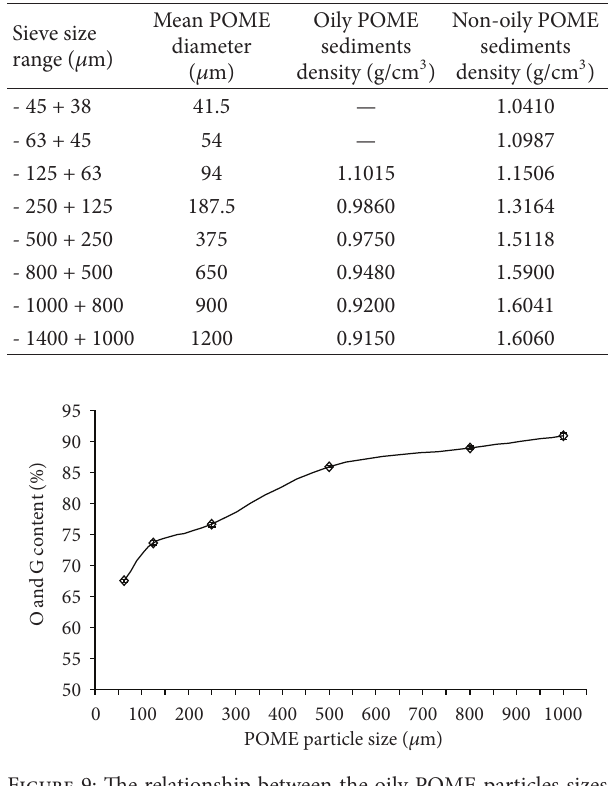
F 9: e relationship between the oily POME particles sizes ( m) and the oil content ( 𝜇𝜇 %